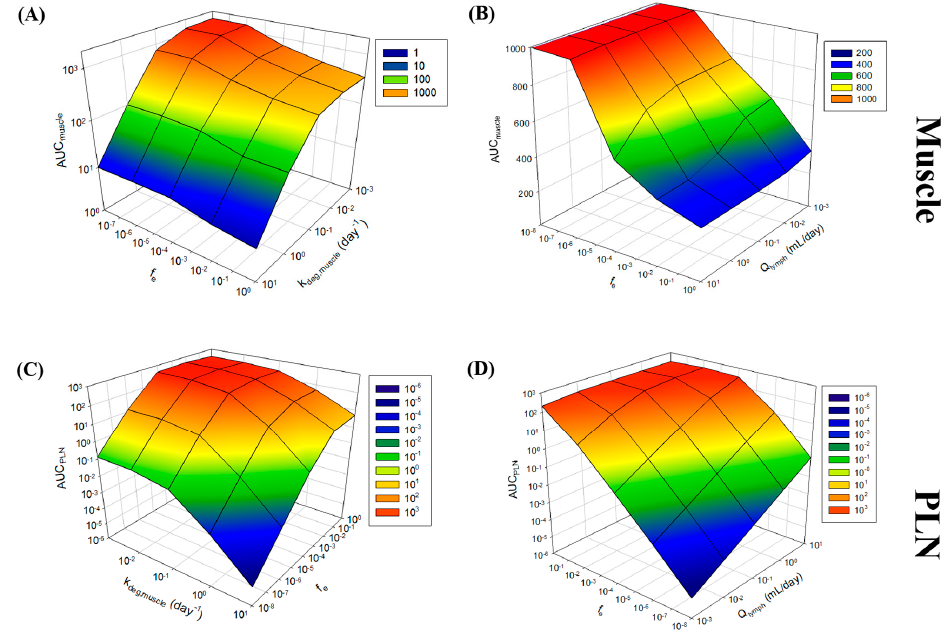
Figure 6. Local sensitivity analysis of f e , k deg , Q muscle and Q lymph towards AUC muscle ( A , B ) or AUC PLN ( C , D ). Note the differences in the z-axis scales.